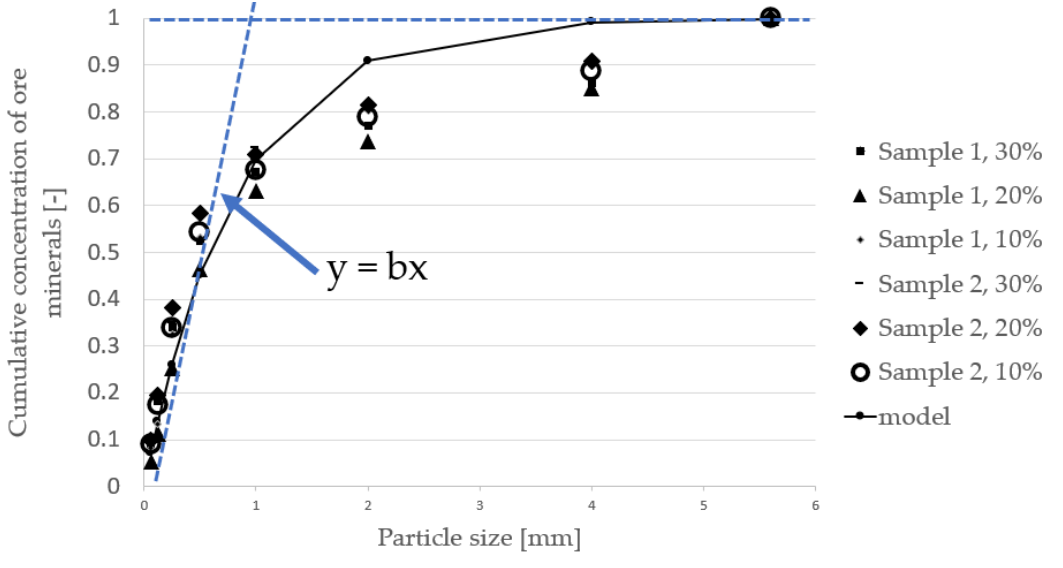
Figure 5. A cumulative analysis of tantalum content in fraction sizes from the experimental data.